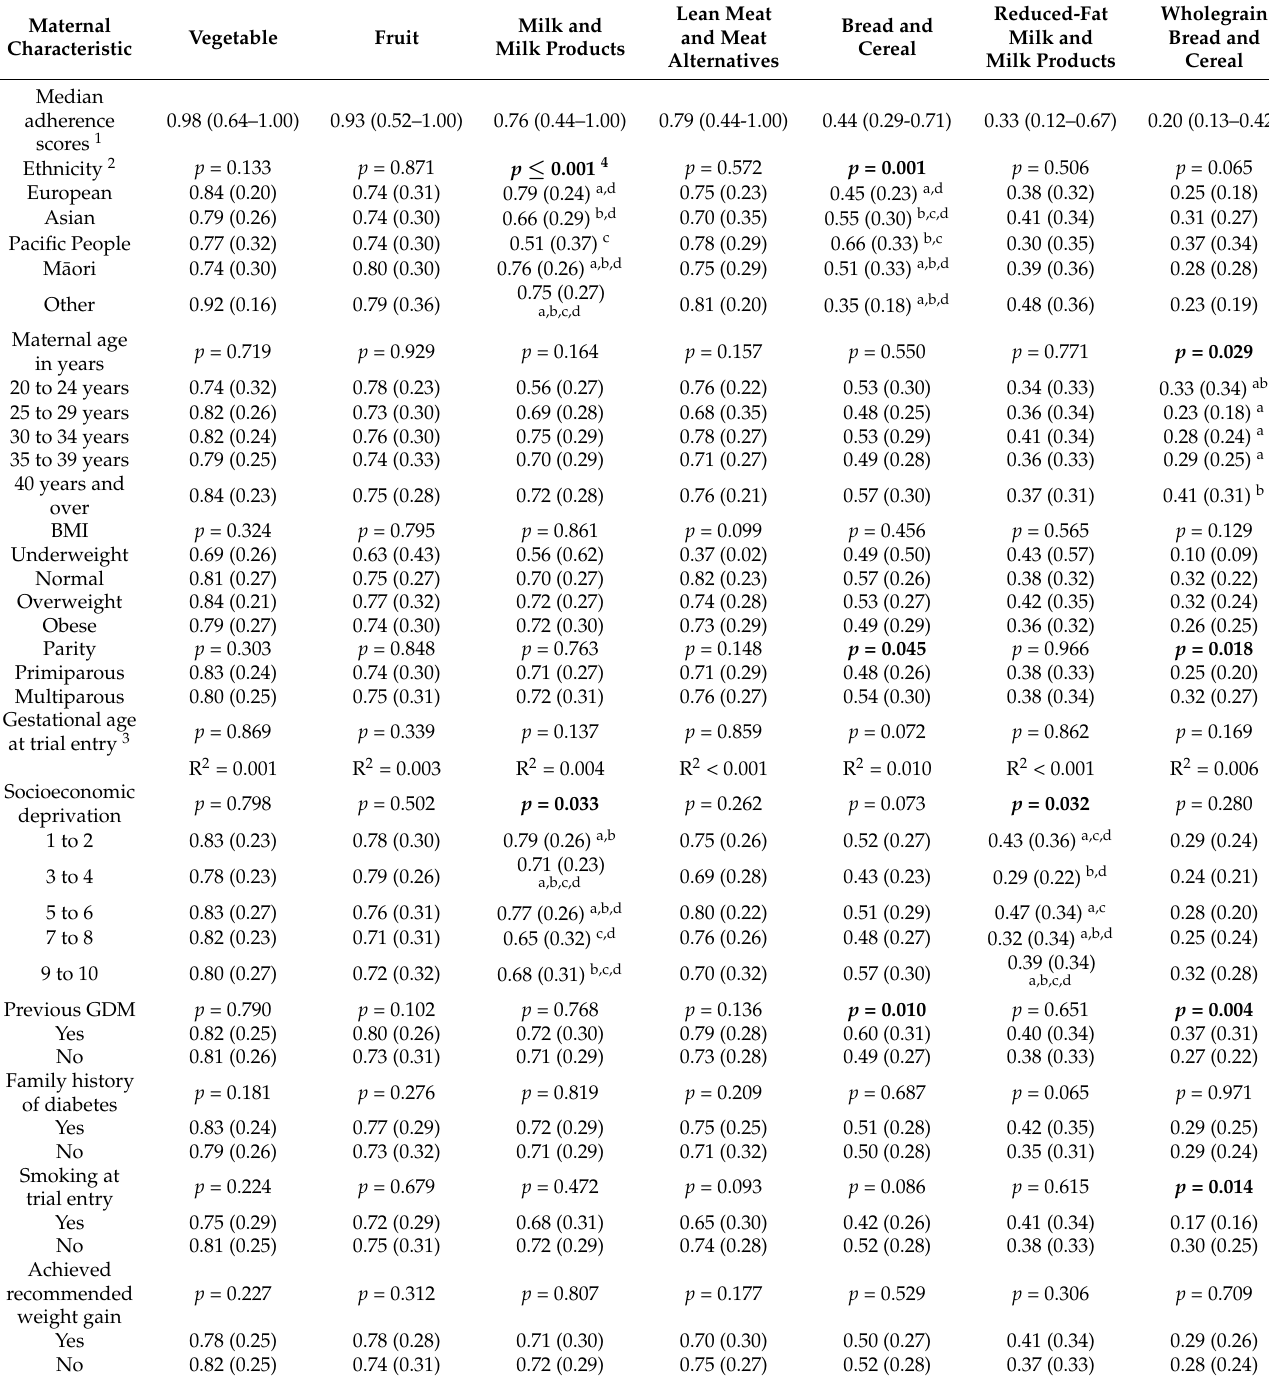
Table 5. Maternal characteristics and demographics associated with dietary scores of the seven food